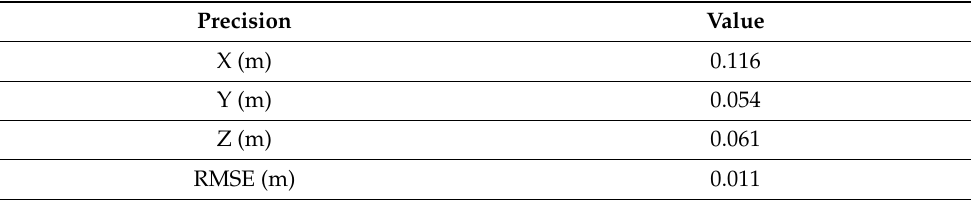
Table 2. Sample of the GCPs’ accuracy obtained after the field survey (Amra2). Precision Value X (m)